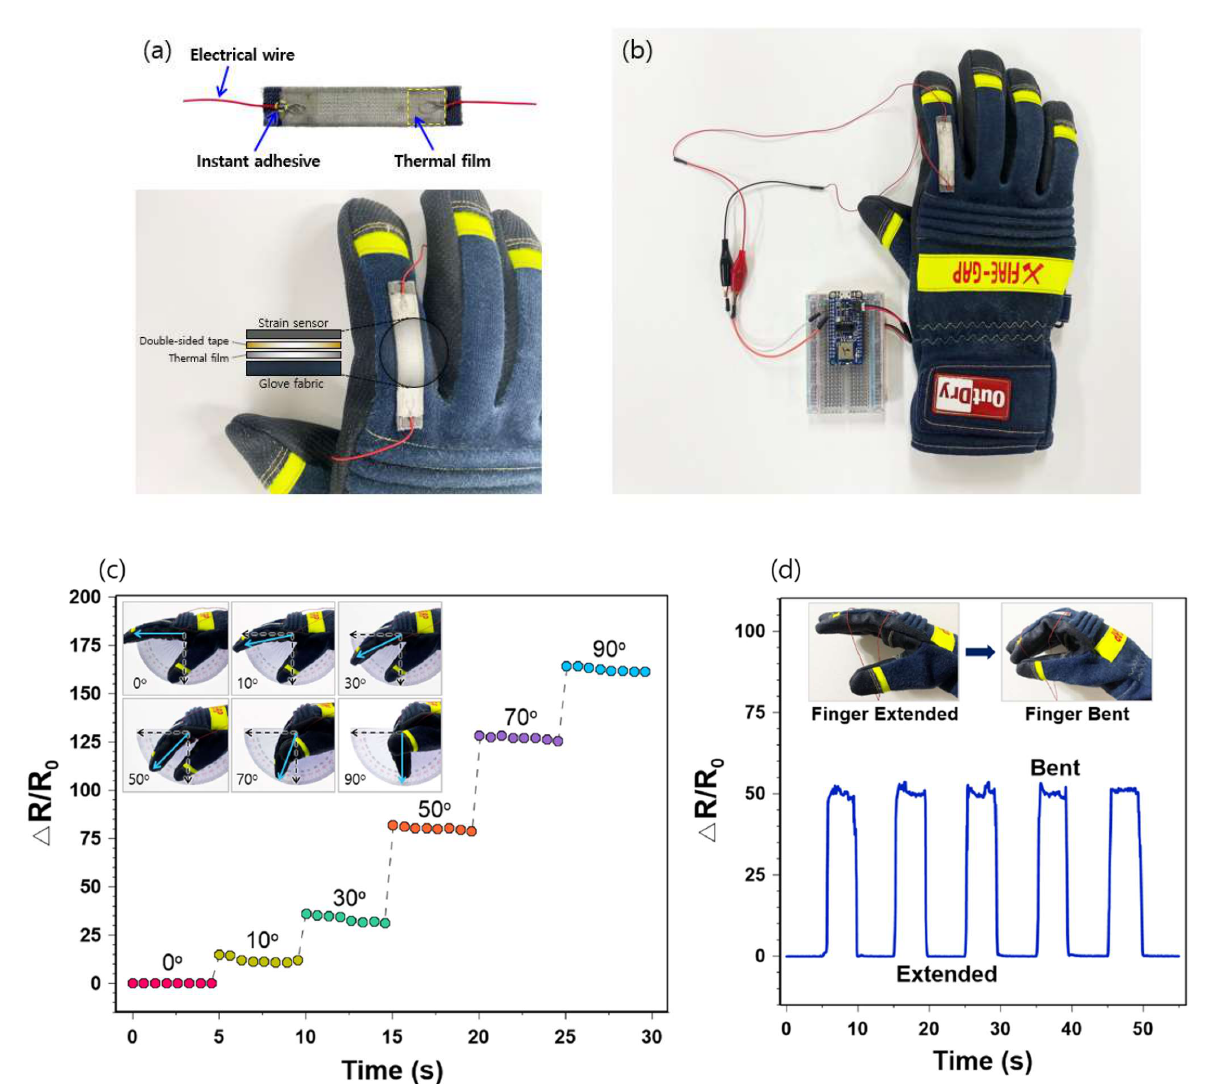
Figure 8. ( a ) Structure of the sensor integrated into the firefighters’ glove; ( b ) Prototype of the finger-motion-sensing firefighter’s glove; ( c ) Relative resistance changes of finger bending at different angles; ( d ) Relative resistance changes of cyclic finger motions of extending and bending.